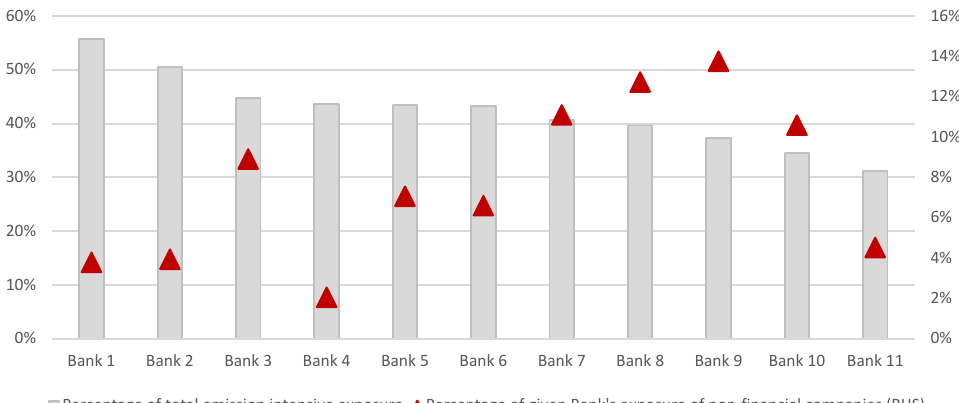
Figure 8. The major exposure of Poland’s commercial banks to the country’s emission-intensive sectors.